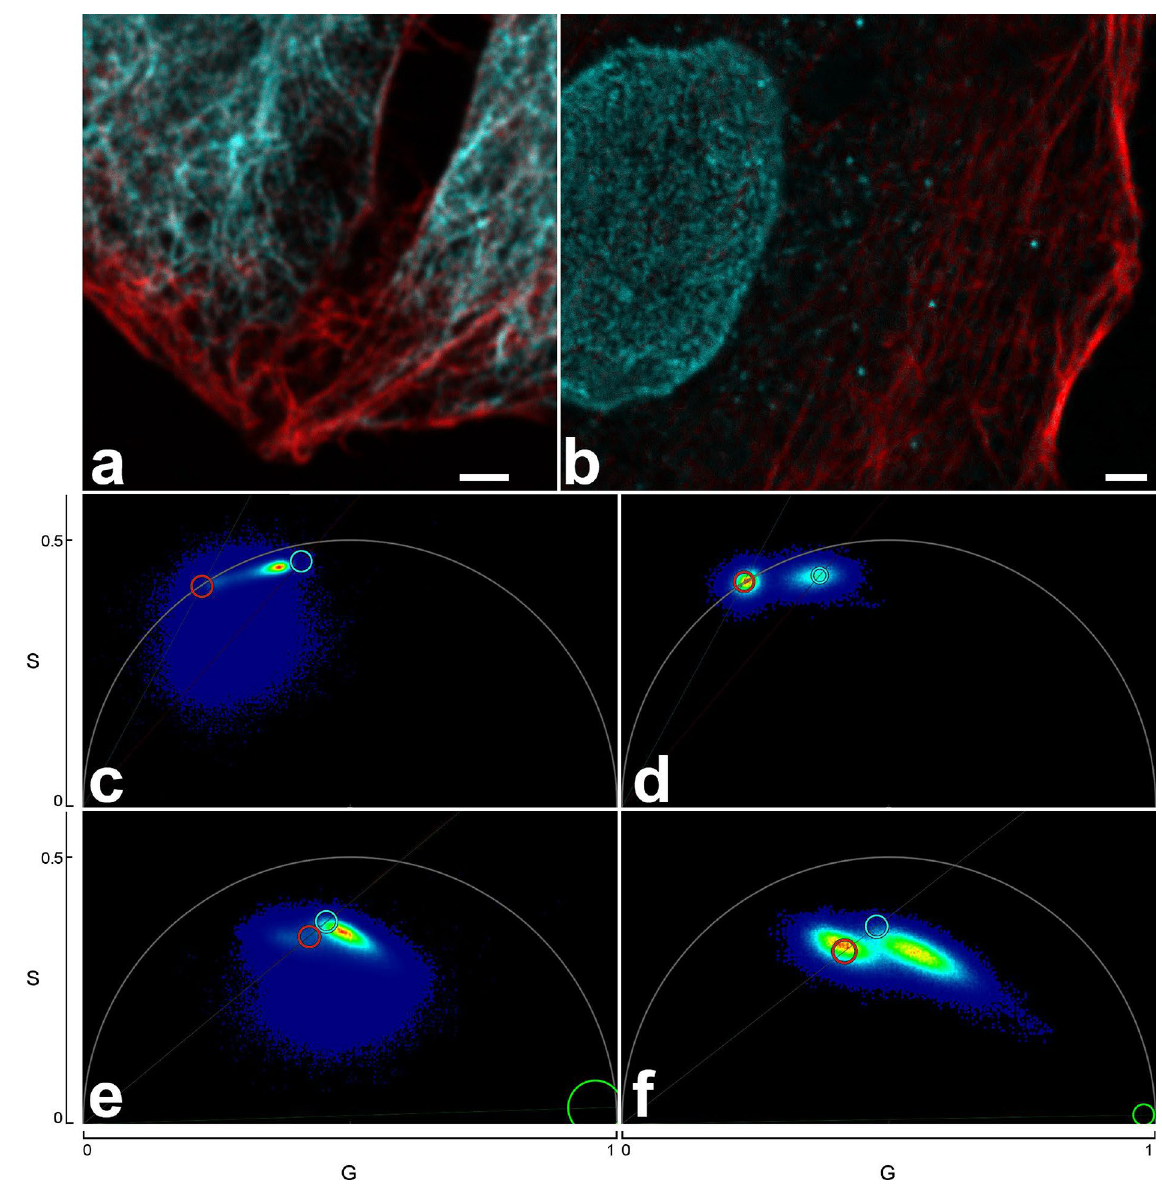
Figure 4. Fluorochromes have different lifetimes when coupled to antibodies or to phalloidin. ( a ) Confocal image of Abberior STAR 635P coupled to an antibody delineating vimentin (cyan) and to phalloidin (actin staining; red) and subjected to phasor based lifetime separation. ( b ) Confocal image of ATTO 647N coupled to phalloidin (actin staining, red) and an antibody (nuclear pores, cyan. Both confocal images show good separation of the two stained structures. Scale bars 2 µm. ( c , d ) Phasor plots for the complete raw images of ( a , b ). The actin coupled dyes have longer lifetimes (left cloud, red circle) compared to their antibody-conjugated versions (right cloud, cyan circle). ( e , f ) Phasor plots of respective STED images show that the lifetime differences are much reduced, due to the depletion effect causing a shorter average lifetime. Therefore, despite inclusion of a background component (green circle at G = 1, S = 0), separation of STED images was not satisfying and resulting images are not shown. Cyan and red circles indicate the best possible positions for separation of the two species. In ( e , f ) the right-hand clouds contain the pixels with antibody label derived photons, but they also contain substantial amounts of actin label derived photons. To compensate for this the circles were positioned next to the